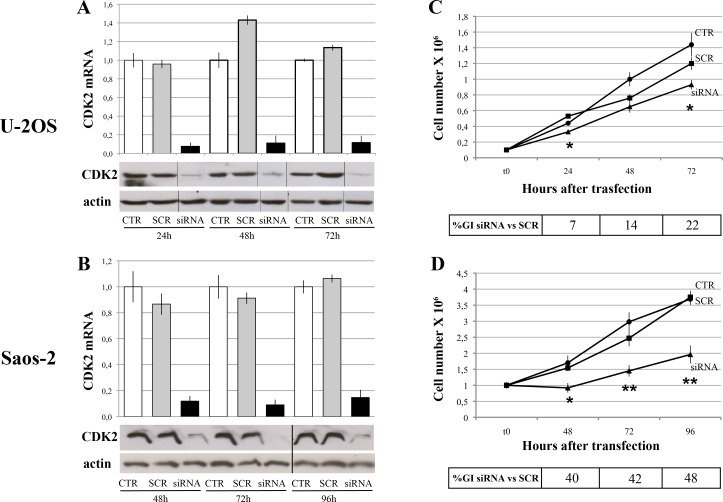
CDK2 gene and protein knock-down after siRNA transfection in U-2OS (A) and Saos-2 (B) human osteosarcoma cell lines. CDK2 mRNA and protein levels were assessed at different time points after the end of siRNA treatment (from 24 to 72 h for U-2OS; from 48 to 96 h for Saos-2). At the same time points, the extent of growth inhibition induced by CDK2 silencing was also estimated (C-D). Asterisks indicate statistically significant differences between SCR and siRNA treatments (** P<0.01 and * 0.01<P<0.05 by Student’s t test). Data refer to three different experiments and western blot images are representative of these determinations. Black lines show where the original gel (S1 Fig) was cropped to obtain the final image. Legend: CTR, control, not-treated cells; SCR, cells transfected with scrambled siRNA; siRNA, cells transfected with anti-CDK2 siRNA; h, hours after siRNA transfection; %GI, percentage of growth inhibition.